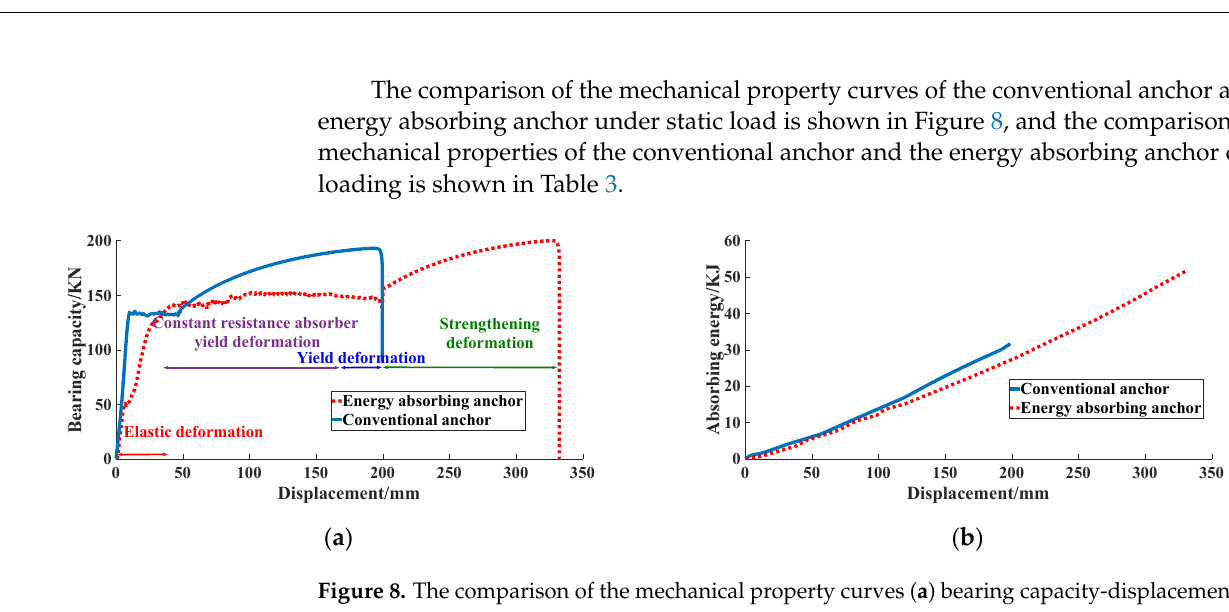
Figure 7. Constant resistance energy absorber ( a ) Before the test; ( b ) After the test.